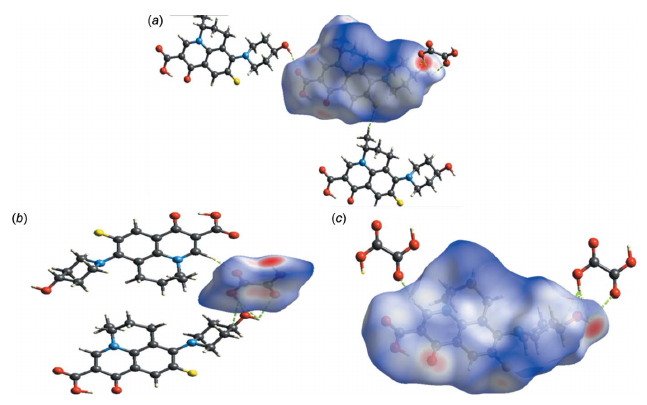
Figure 5 Calculated Hirshfeld surfaces mapped over d norm for ( a ) NAD, ( b ) OA and ( c ) the NAD–OA co-crystal to visualize the intermolecular interactions.